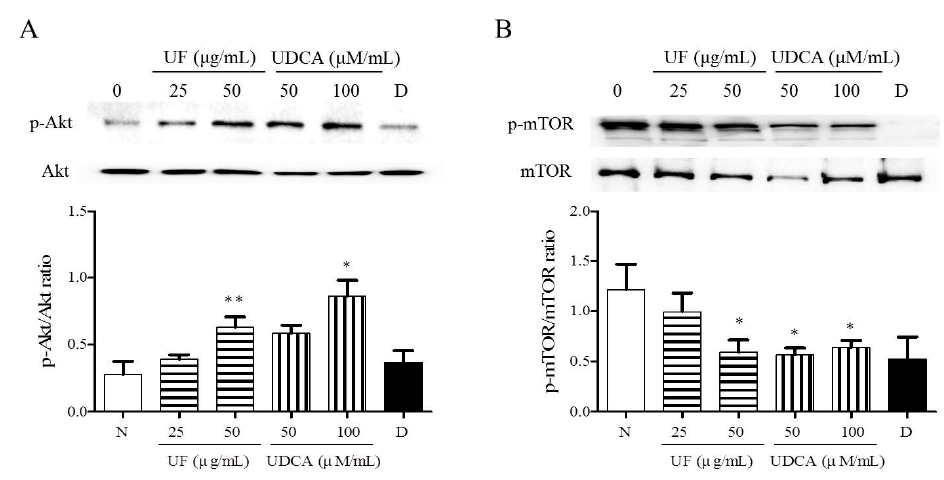
Figure 5. Effects of UF extract and UDCA on the phosphorylation of mTOR and Akt in human FRO anaplastic thyroid cancer cells. The cells were treated with UF extract or UDCA at indicated concentrations for 48 h. The expression of phosphorylated Akt ( A ) and mTOR ( B ) was determined by western blotting. The phosphorylation level of each protein was calculated relative to the ex- pression of their total content. Data are representative of three independent experiments. * p < 0.05 and ** p < 0.01 vs. normal cells. N, untreated cells; UF25, 25 µ g/mL UF extract treatment; UF50, 50 µ g/mL UF extract treatment; UDCA50, 50 µ M/mL UDCA treatment; UDCA100, 100 µ M/mL UDCA treatment; D, 2 nM/mL docetaxel treatment.